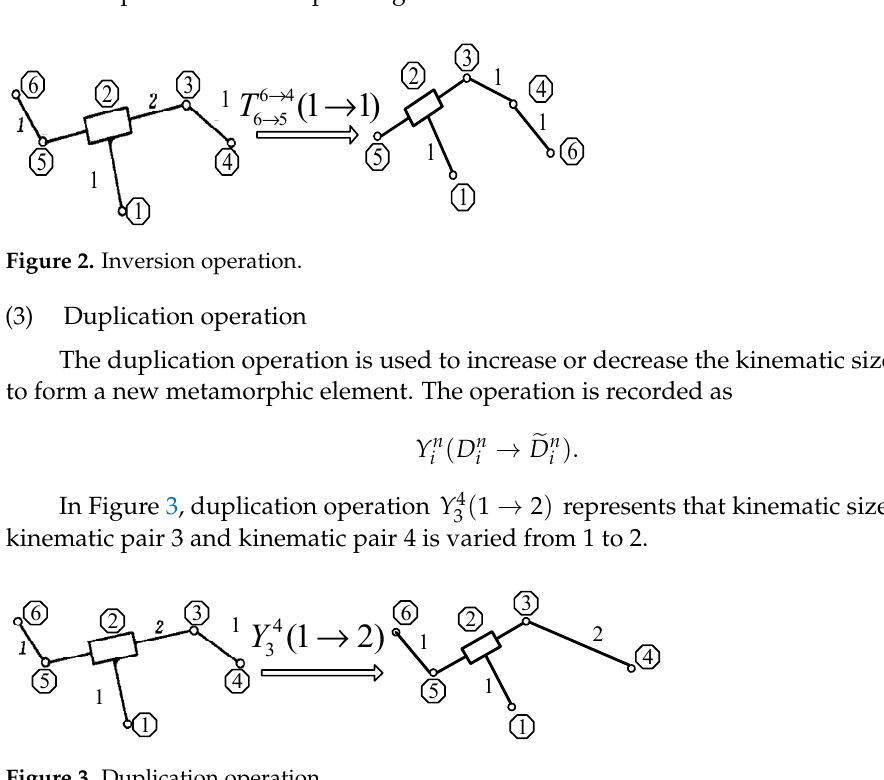
Figure 1. Translocation operation.